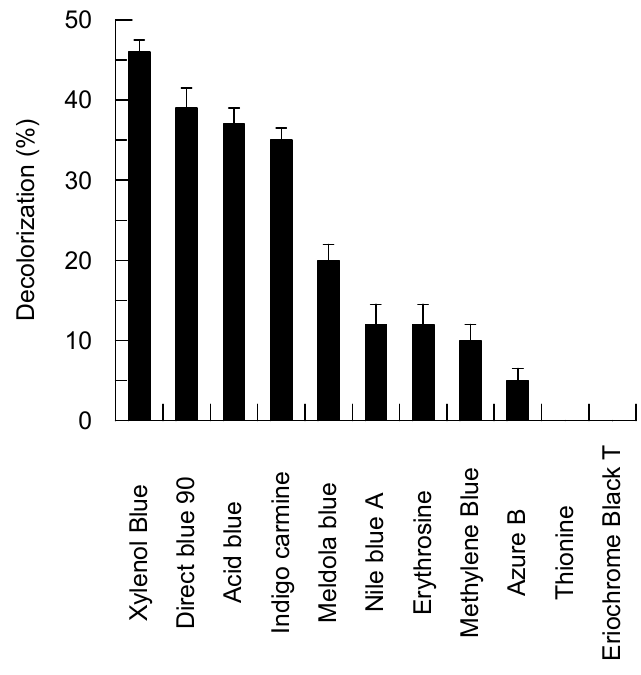
Figure 4. Decolorization of the synthetic dyes by the Bcl1 laccase.